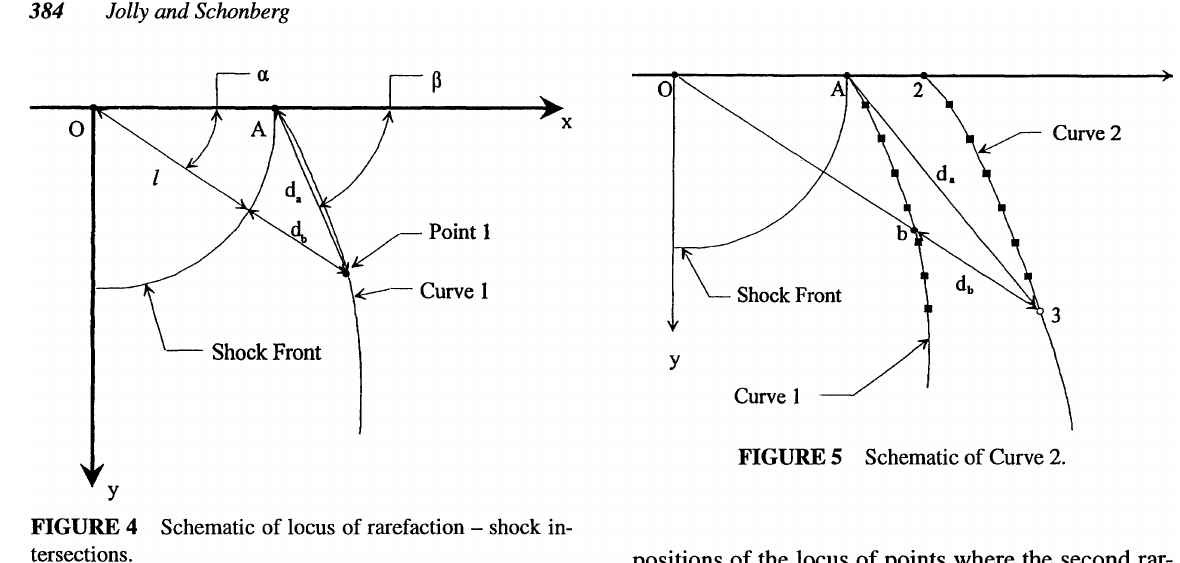
FIGURE 4 Schematic of locus of rarefaction - shock in tersections.